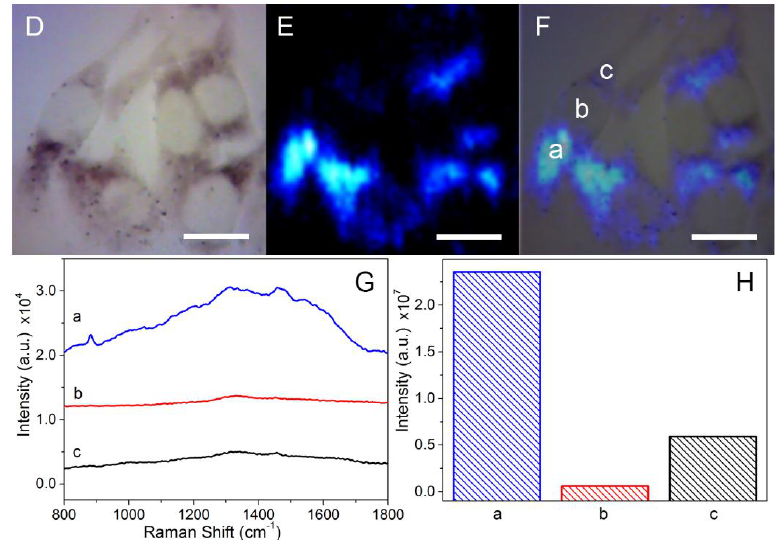
Figure 4. Raman imaging of B16-F10 cells ( A – C ) without or ( D – F ) with intercellular Melanin–Ag nanocomposites. ( A , D ) Typical bright-field images; ( B , E ) Raman images; and ( C , F ) the overlap images of B16-F10 cells. The SERS spectra of the different spots (a, b, and c) marked in ( F ) and corresponding quantitative data are shown in ( G , H ), respectively. Scale bar = 20 μm.